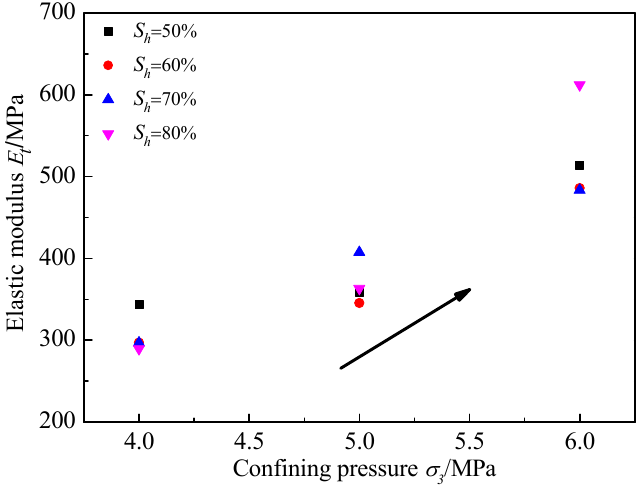
Figure 15. Variation of the elastic modulus with the confining pressure.